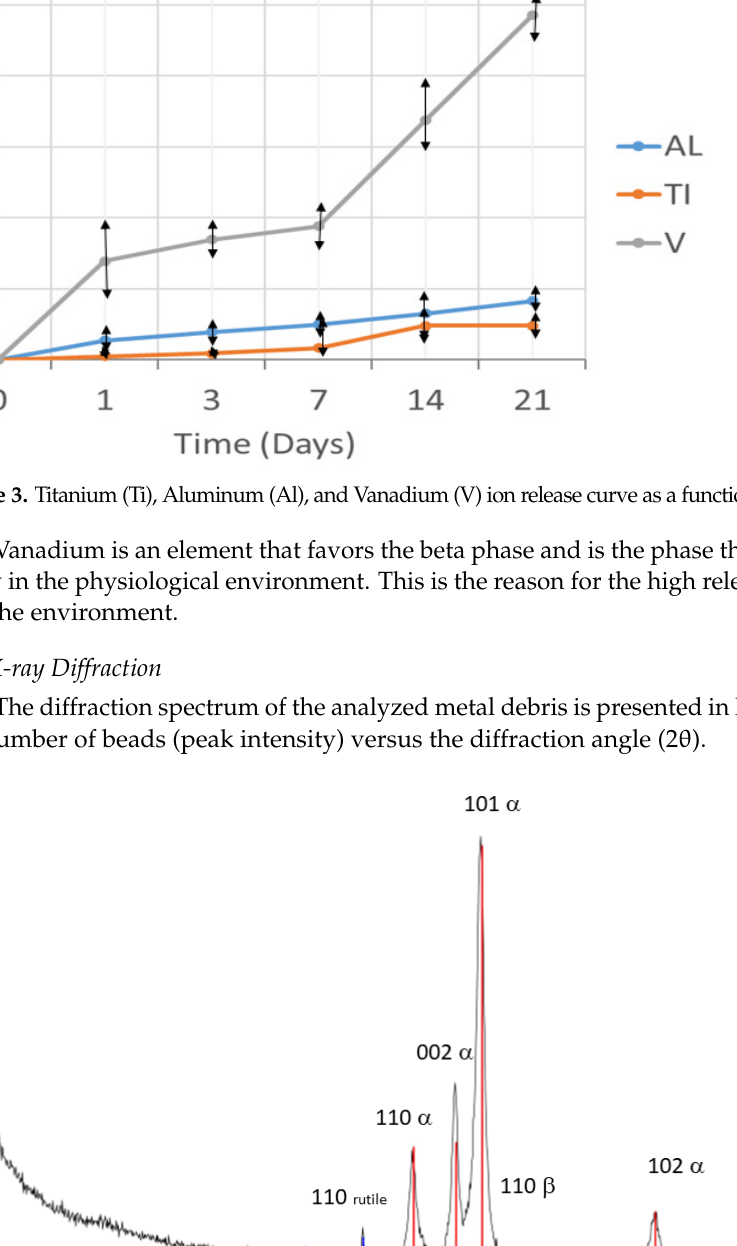
Figure 5. Representation of the sorption (mass increase as a function of time) of several samples of metal debris. 3.7. Citotoxicity The results of the cytotoxicity assay expressed as percentage cell survival are illus- trated in Figure 6. The cells were adherent to the substrate plate and presented the ex- pected morphology, both before and after incubation with the extracts. The sample under evaluation exhibited cytotoxic effects in both the osteoblastic and fibroblast cell assays in the whole extract (undiluted). In contrast, it showed no cytotoxic